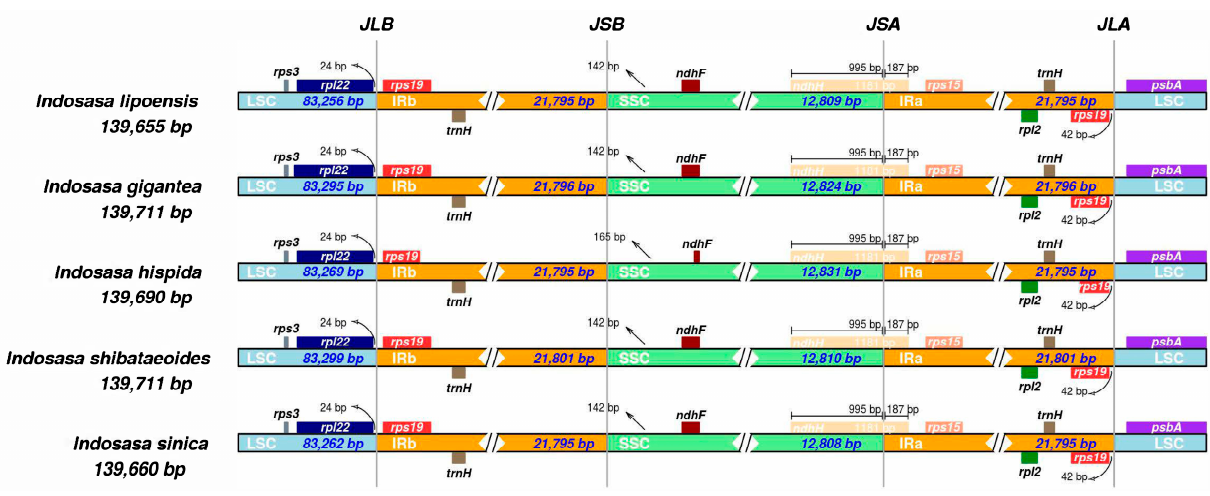
Figure 5. Comparisons of the LSC, SSC, and IRs junctions among the Indosasa species.